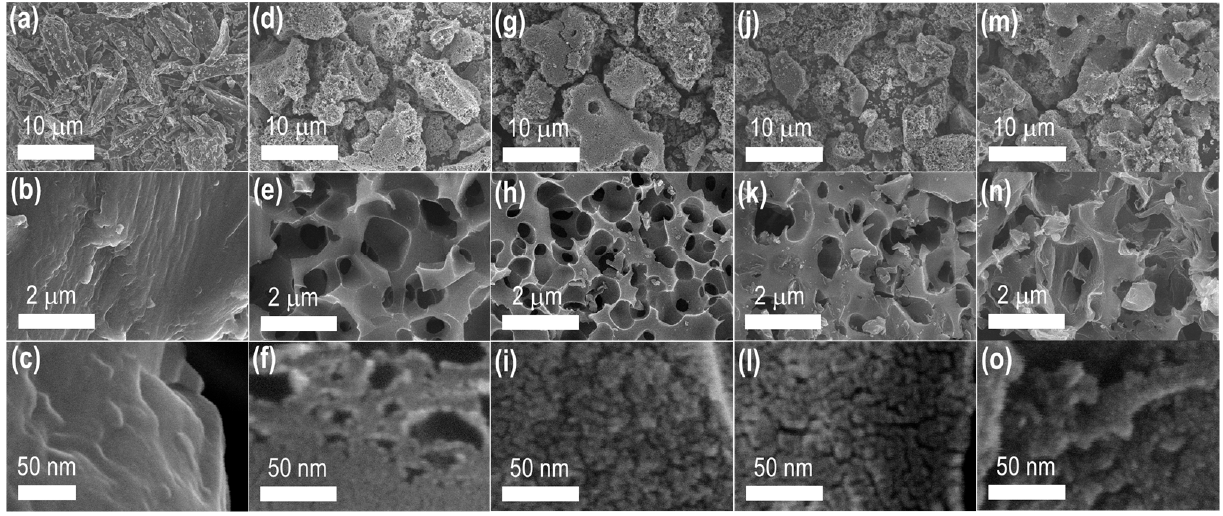
Figure 4. Surface morphology of the Amala seed carbons: SEM images of ( a – c ) AmP_900; ( d – f ) AmC_K700; ( g – i ) AmC_K800; ( j – l ) AmC_K900; and ( m – o ) AmC_K1000.